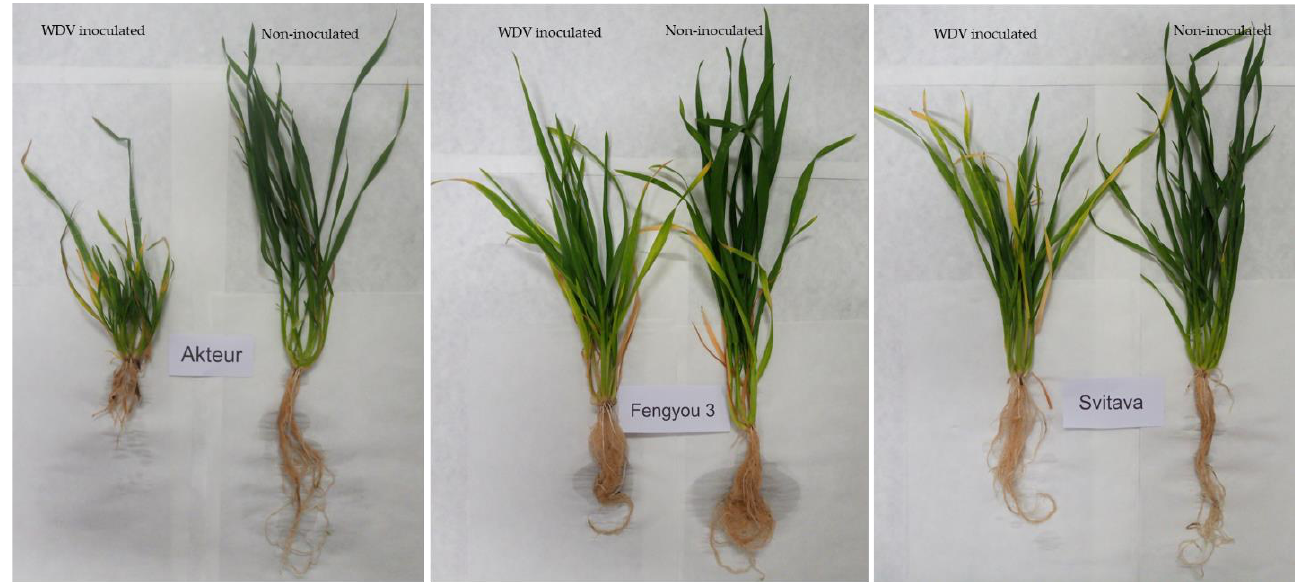
Figure 1. Disease symptoms (80 days post-inoculation) in each tested wheat genotypes (WDV inoculated and non-inoculated control).